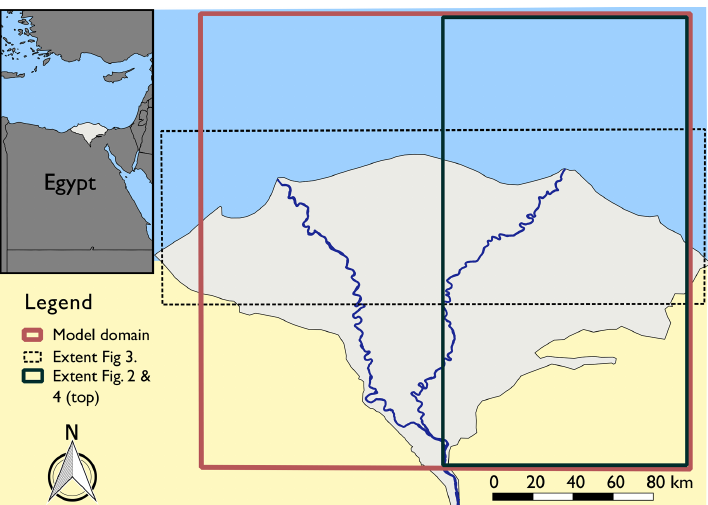
Figure A1. Overview of the Nile Delta with boxes indicating the model domain and the extents of several figures. The main Nile river branches are plotted as a geographical reference. The red rectangle shows the extent of our model domain, the dark green box the plotted area in Fig. 2 and the top half of Fig. 4, and the dotted box the plotted area in Fig. 3. The inset in the upper-left corner shows the location of the Nile Delta in Egypt.